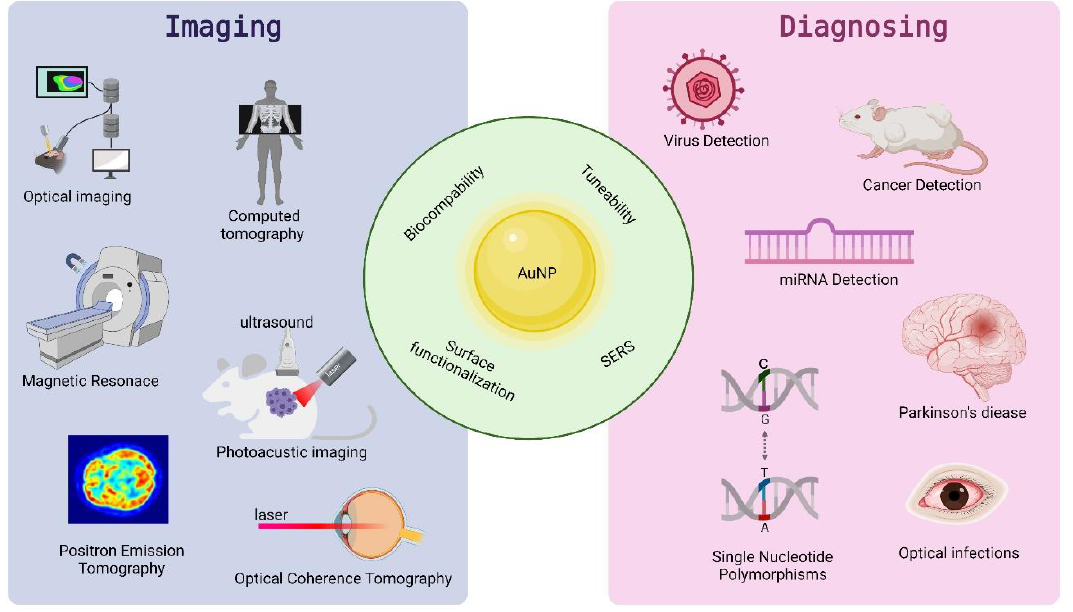
Figure 3. Properties and application of AuNPs in imaging and Figure 3 . Properties and application of AuNPs in imaging and diagnosing .